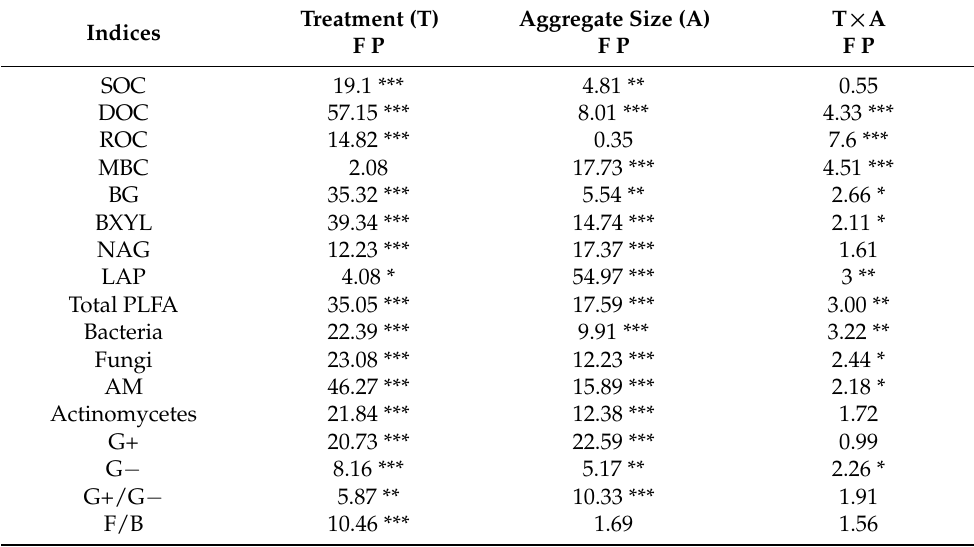
Table 2. Two-way ANOVA of fertilization treatment (T), aggregate size (A), and their interaction (T × A) on soil C, enzyme activity, microbial variables, and aggregate